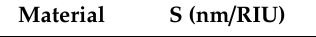
Table 1. Comparison of the refractive index sensitivity of the proposed PCF-SPR when the material of the metal layer are Au and silver.